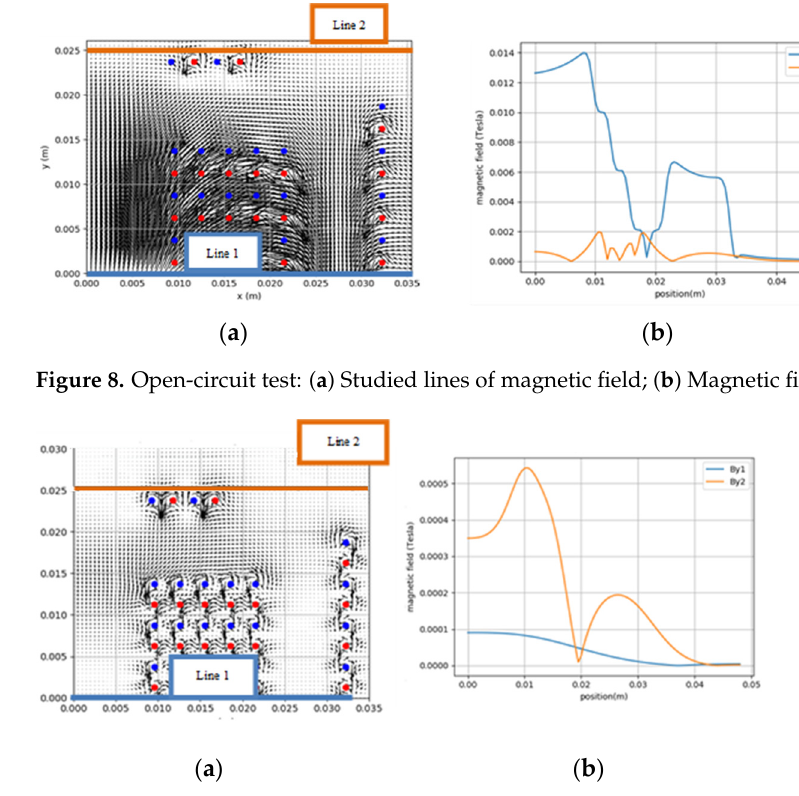
Figure 9. Short circuit test: ( a ) Studied lines of magnetic field; ( b ) Magnetic